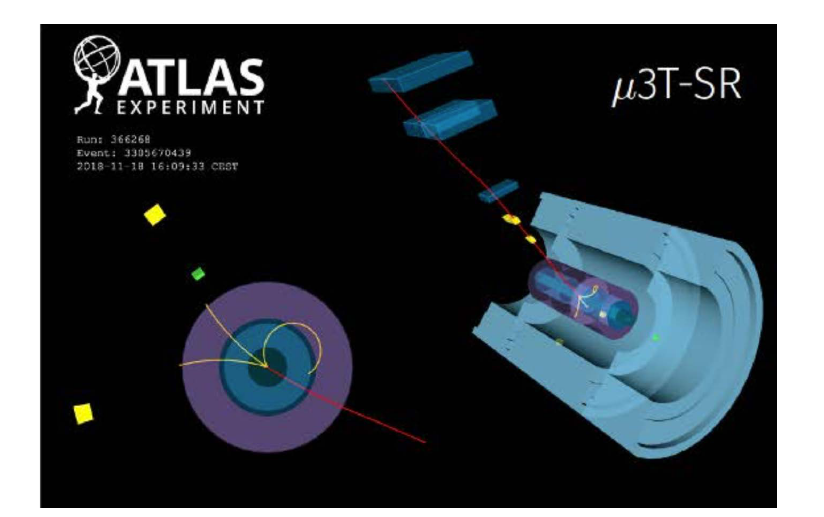
Figure 4. Display of a candidate event in the central ATLAS detector: a muon (red track) + 3 tracks. The muon is measured by the muon-spectrometer while the tracks are measured by the central ATLAS tracker